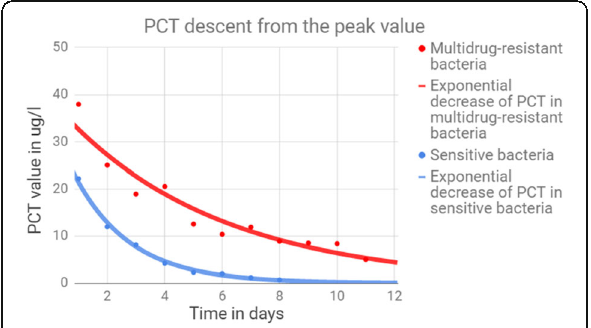
Fig. 1 (abstract 000710). See text for